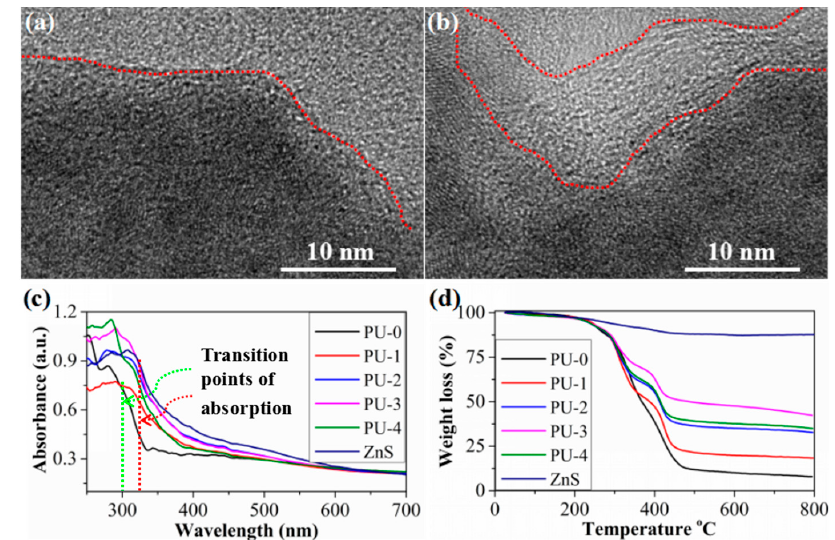
Figure 3. Transmission electron microscope (TEM) images of ZnS quantum dots (QDs) ( a ) on the fiber surfaces of PU-2, ( b ) in the fiber inner of PU-4 (the red dotted curves in Figure 4a,b show the boundary between ZnS and the polymer layer), ( c ) ultraviolet (UV)-vis absorption spectrum (the green and red dotted lines show the transition points of UV-Vis absorption of the PU-0 and ZnS), ( d ) thermal gravimetric analysis (TGA) curves of